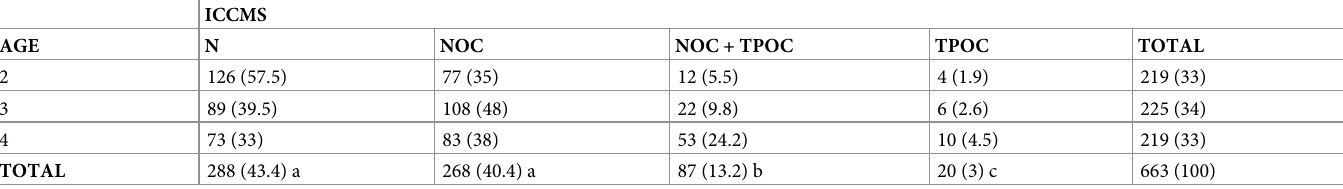
Table 5. Distribution of number and percentage of treatment decision by age